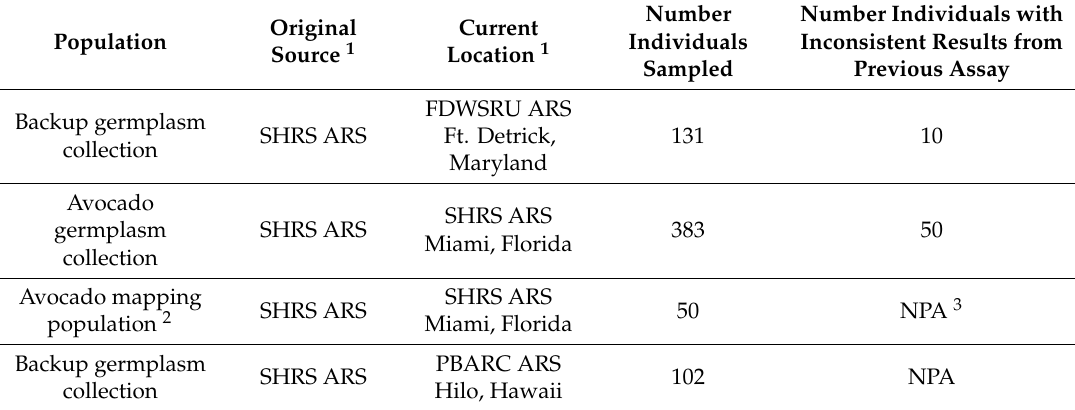
Table 1. Avocado trees that were tested for avocado sunblotch viroid